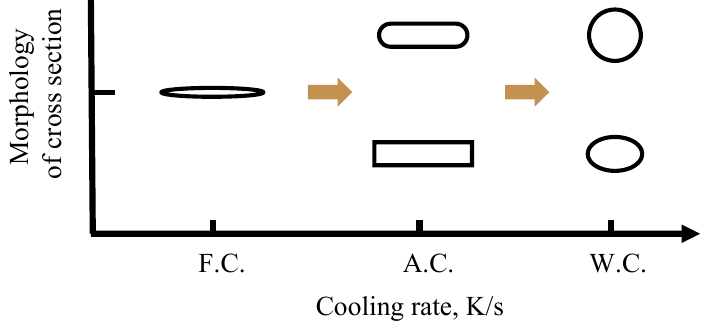
Figure 9. Schematic diagram of the morphology of CaS inclusion under different cooling rates.